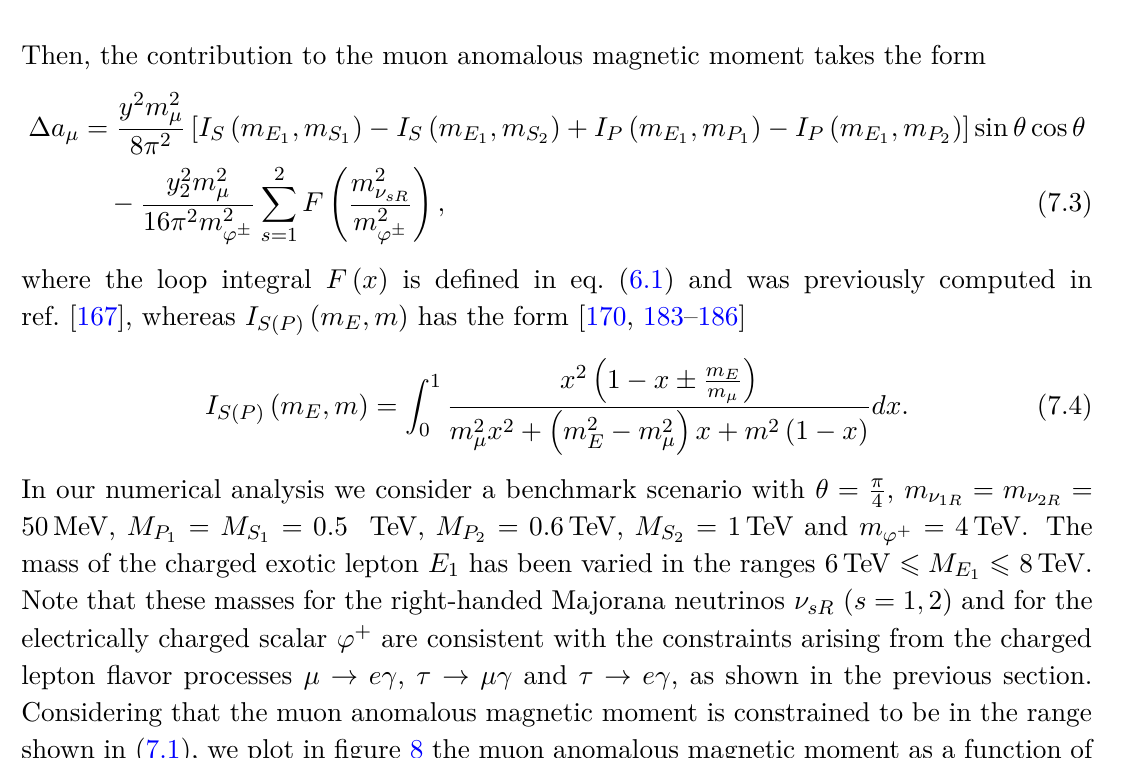
Figure 7 . Leading Feynman-loop diagram contributing to the electron anomalous magnetic mo- ment. Here k = 1 , 2